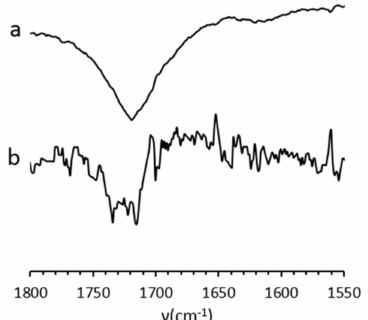
Figure 9. Difference spectra ( SiO 2 @COOH - SiO 2 ) on specific range. (a) with SiO 2 produced in MeOH, (b) with SiO 2 produced in